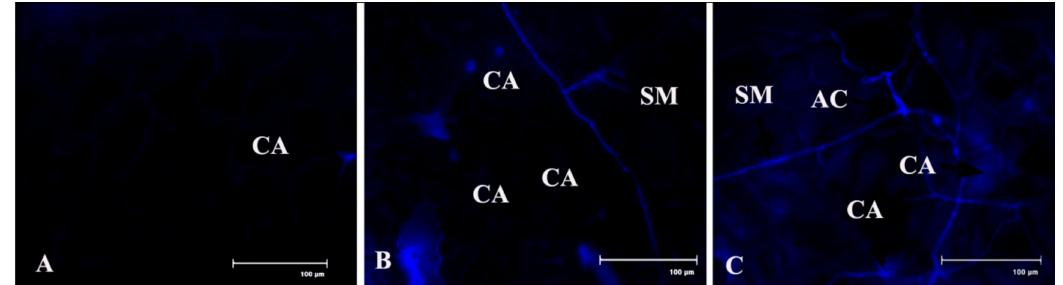
Figure 11. E ff ects of C. gloeosporioides on production of callose in detached bean leaf peel. Real-time callose formation was detected by blue fluorescence in leaf epidermal cells stained by aniline blue: